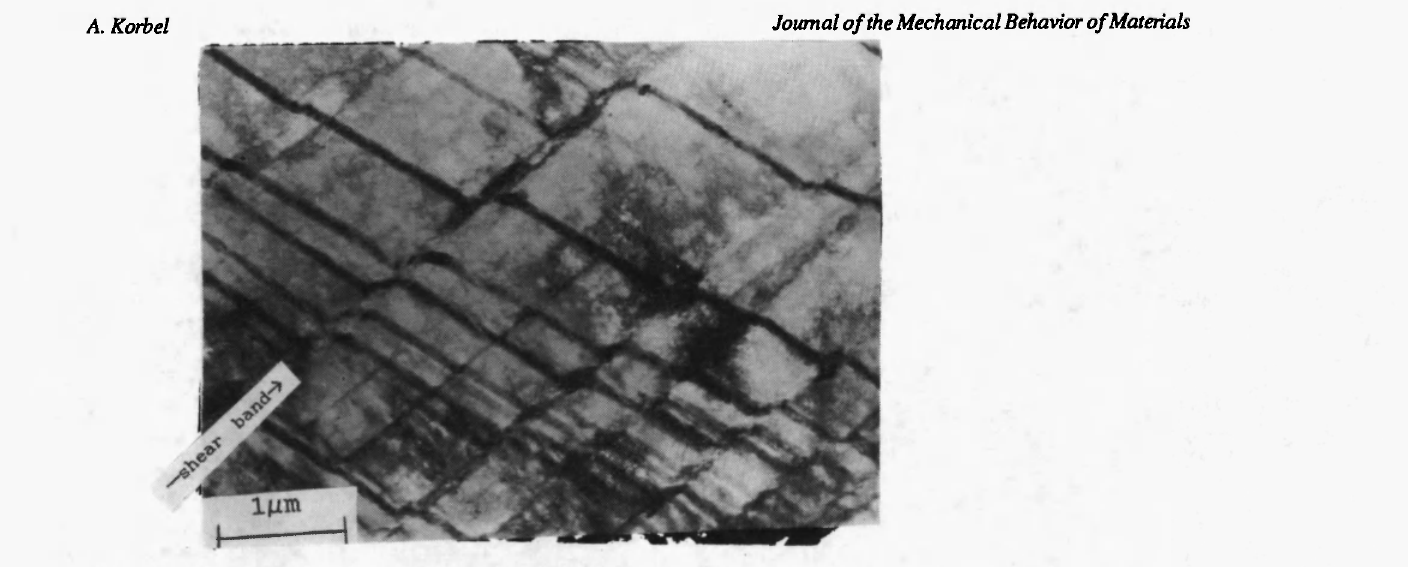
Fig.7. Shearing of the mechanical twins by the secondary deformation